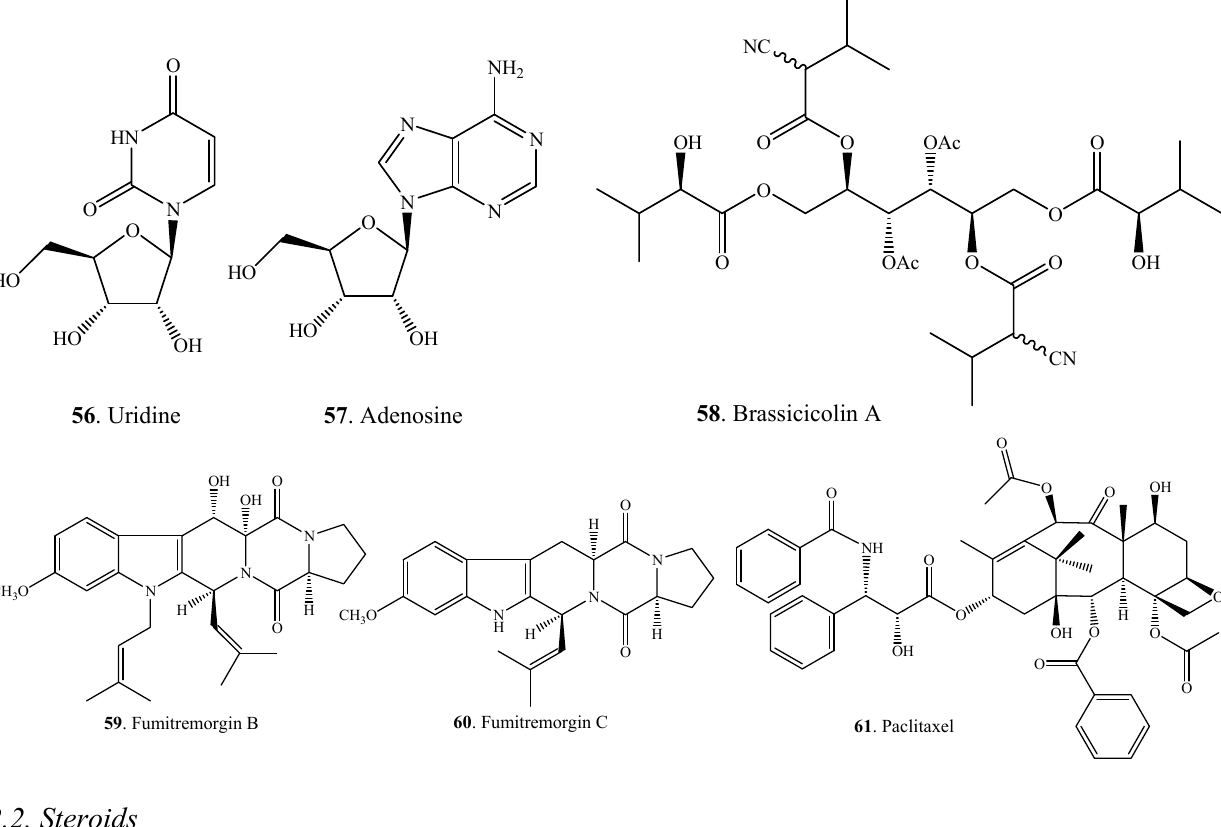
Figure 3. Other nitrogen-containing metabolites isolated from Alternaria fungi.